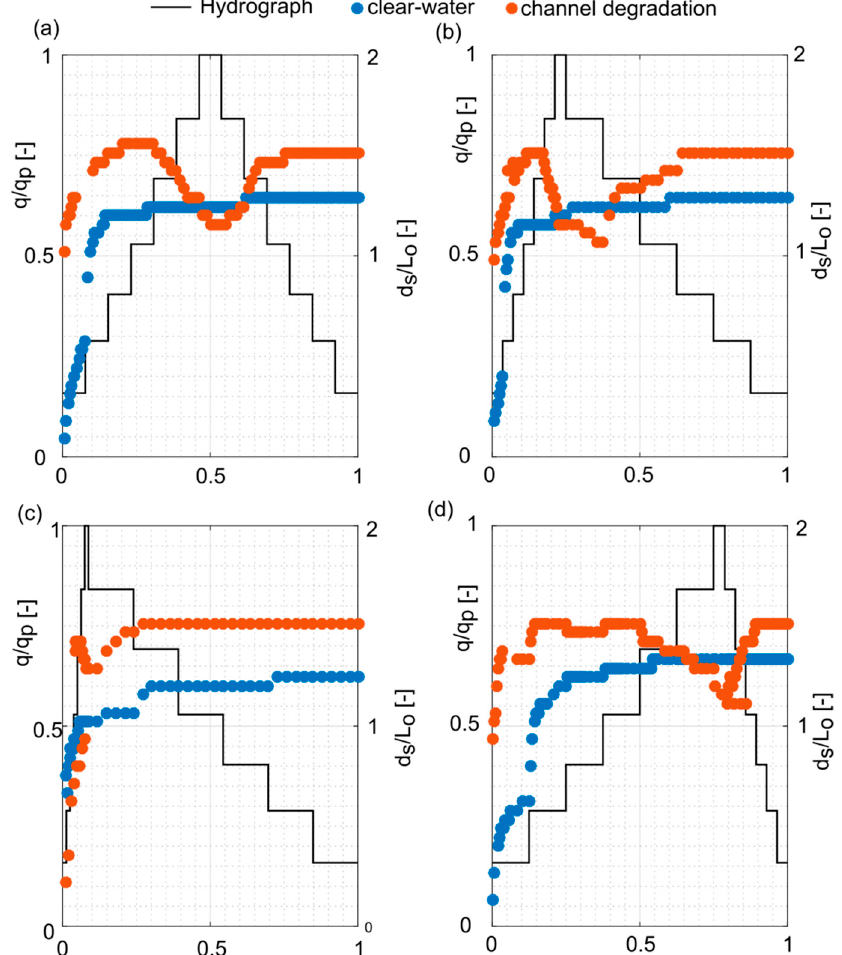
Figure 10. Trajectory of dimensionless scour hole depth (d s /L o ) versus dimensionless time (t/t e ) for general sediment transport and clear-water conditions in Series A experiments and for different hydrograph shapes: ( a ) symmetrical, ( b ) positively skewed, ( c ) flash flood, and ( d ) negatively skewed.